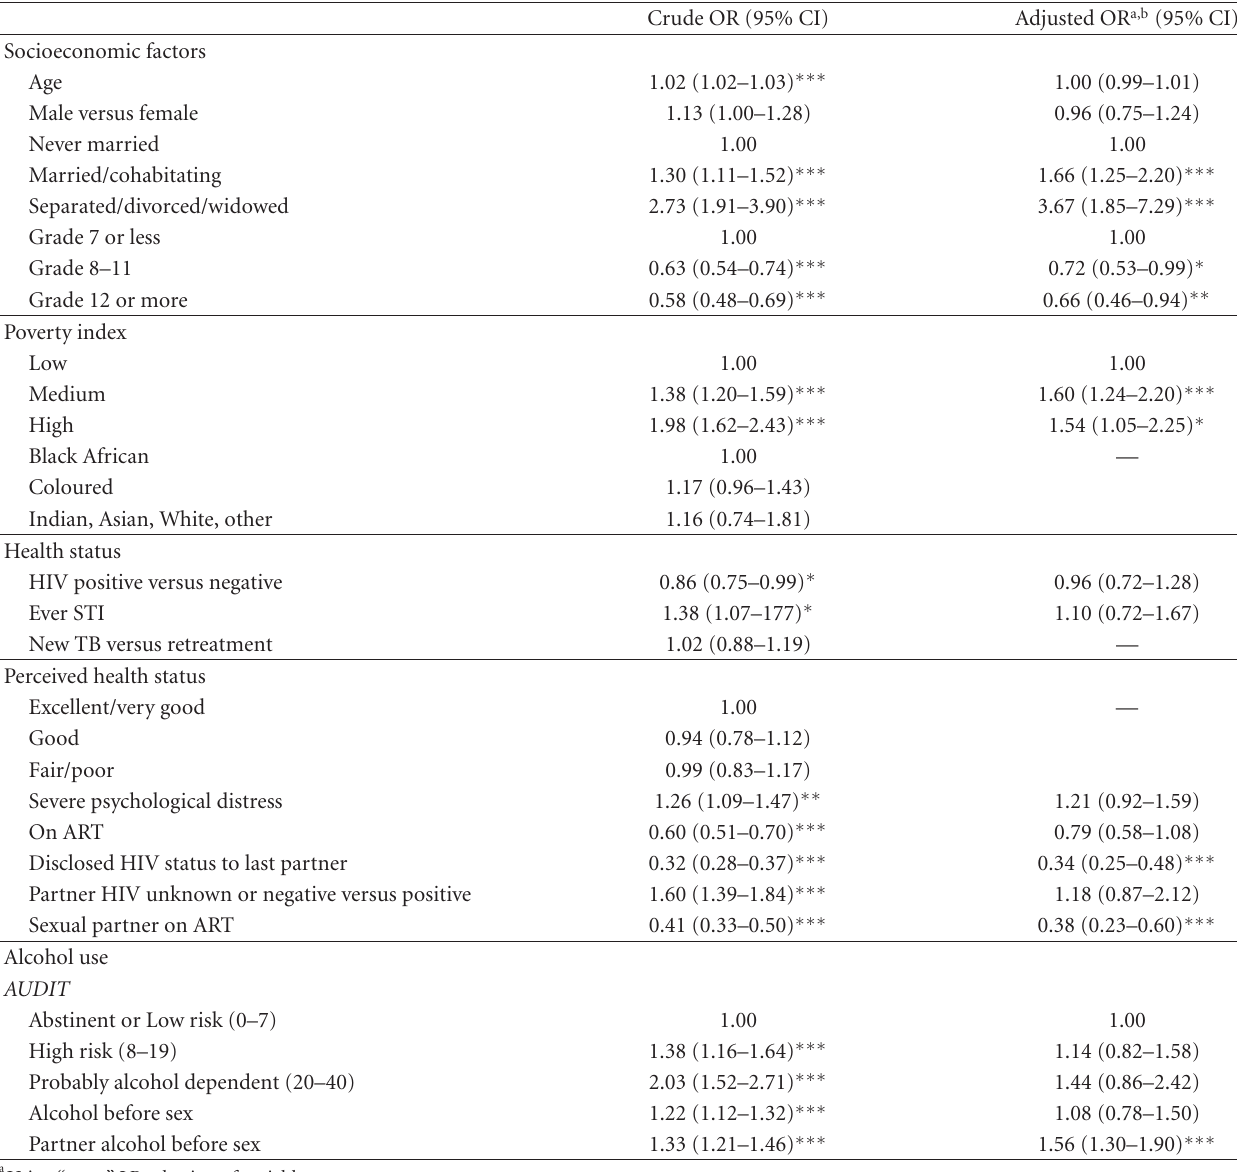
Table 2: Association between inconsistent condom use, socioeconomic factors, health status, and alcohol